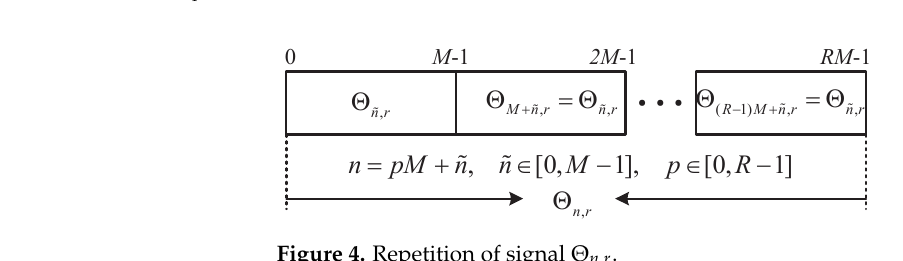
Figure 4. Repetition of signal Θ n , r